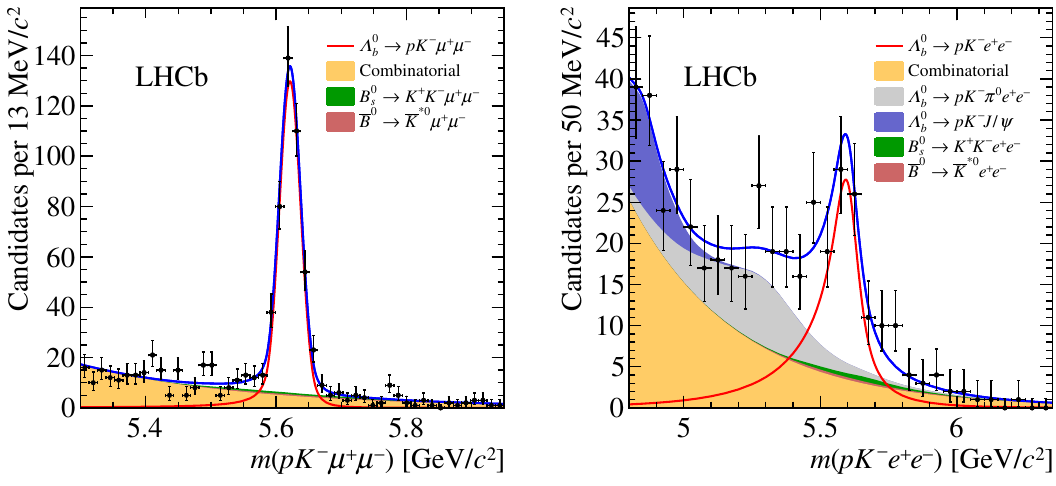
Figure 3. Invariant-mass distribution of (left) (cid:3) 0 ! pK (cid:0) (cid:22) + (cid:22) (cid:0) and (right) (cid:3) 0 ! pK (cid:0) e + e (cid:0) b b candidates summed over trigger and data-taking categories. The black points represent the data, while the solid blue curve shows the total PDF. The signal component is represented by the red curve and the combinatorial, B 0 ! K (cid:3) 0 ‘ + ‘ (cid:0) and B 0 ! K + K (cid:0) ‘ + ‘ (cid:0) components by yellow, brown s and green (cid:12)lled histograms. In the electron model, the grey and blue (cid:12)lled histograms represent the partially reconstructed and (cid:3) 0 ! pK (cid:0) J= ( ! e + e (cid:0) ) b